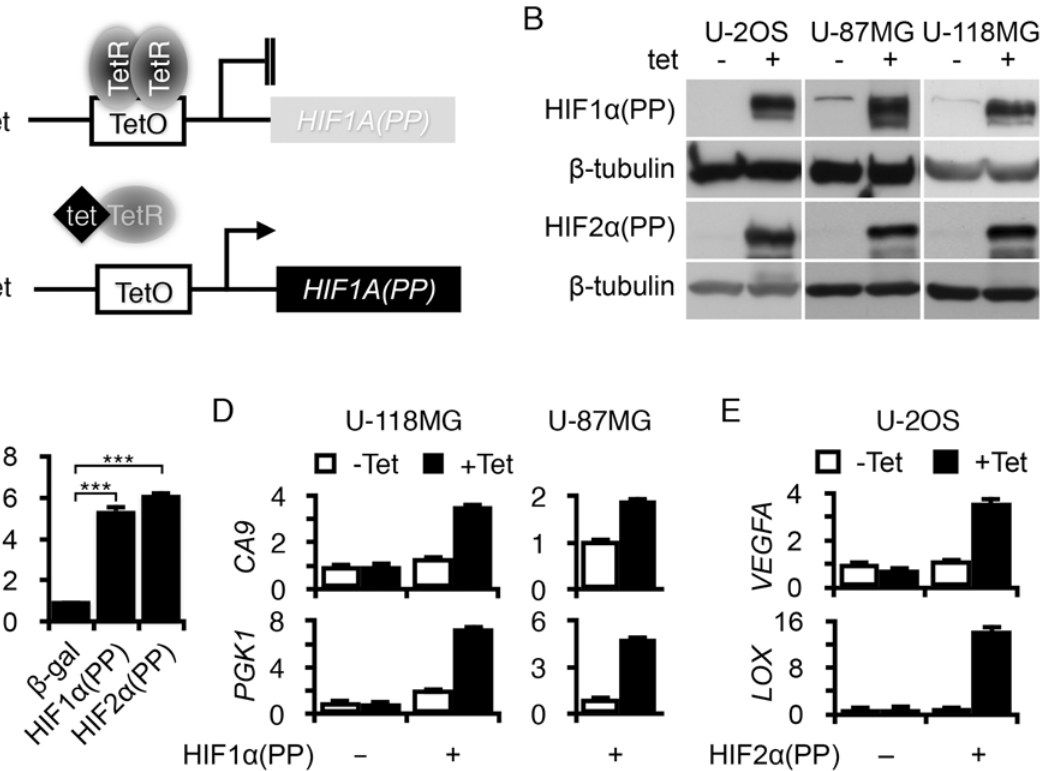
Fig 1. Tetracycline regulation of HIF1 α (PP) and HIF2 α (PP) expression and transcriptional activity. (A) Tetracycline regulation is diagrammed where the addition of tetracycline (tet) results in dissociation of tetracycline repressor (TetR) from the tetracycline operon (TetO) and, in turn, gene activation. (B) Western blot analysis of transduced cell types, as indicated, for the expression of HIF1 α (PP) and HIF2 α (PP) after 2-day treatment with tetracycline. (C) Transcriptional activities of HIF1 α (PP) and HIF2 α (PP) were tested in a reporter assay in reference to β -galactosidase ( β -gal). *** , p -value < 0.001. (D, E) The expression of HIF target genes ( PGK1 , CA9 , VEGFA , and LOX ) was analyzed in specified cell lines by using real-time PCR after 2-day treatment with tetracycline.